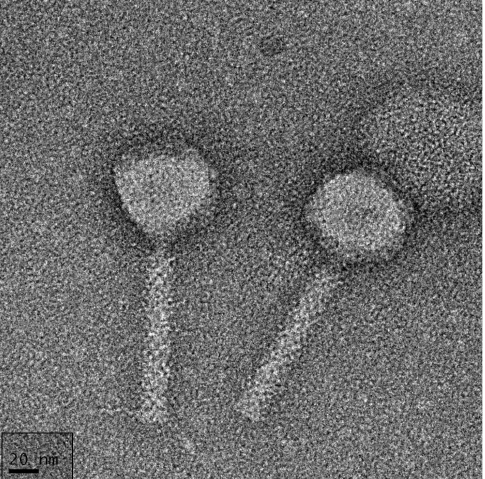
Figure 1. Transmission electron micrograph of 4HA13. Phage particles show the icosahedral head and uncontracted tail. Also visible are the striations from the tail tube proteins and some tail fibers. The image was altered to include the scale bar in the same orientation as the phage particles. Scale bar = 20